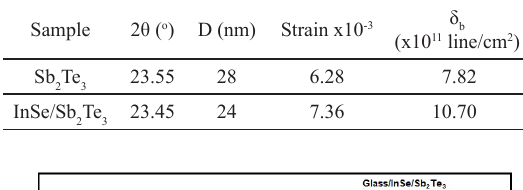
Figure 1. The X-ray diffraction patterns for InSe and InSe/Sb bilayers. The inset shows the geometrical design of the